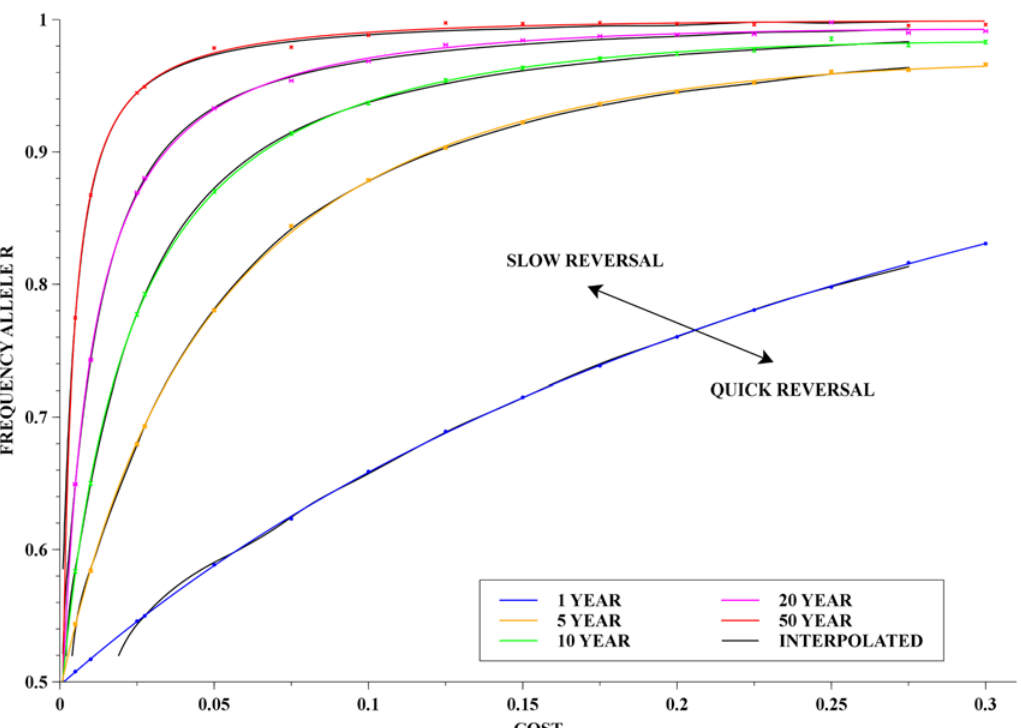
Fig 7. Reversal time contours. Level curves of various reversal times in the cost and initial frequency domain. The colour lines were obtained by the least- squares fitting method whilst the thin black curves were obtained from the interpolated surface — see main text for detailed